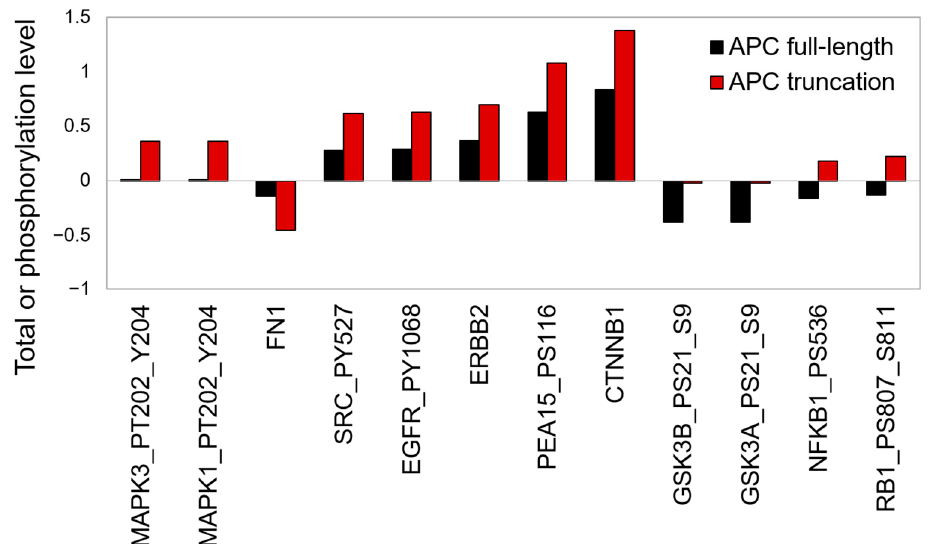
Figure 3. ERK1/2 phosphorylation in the TCGA cohort is associated with APC truncation. The protein expression and phosphorylation levels of CRC patients (COAD in TCGA) were retrieved and compared between APC full-length (black bars) and truncated APC (red bars) patients. Data with a q-value (adjusted p -value by Benjamini–Hochberg correction) less than 0.05 are shown and ranked based on fold changes. Phosphorylation information is annotated by official gene symbol followed by phosphorylation sites.